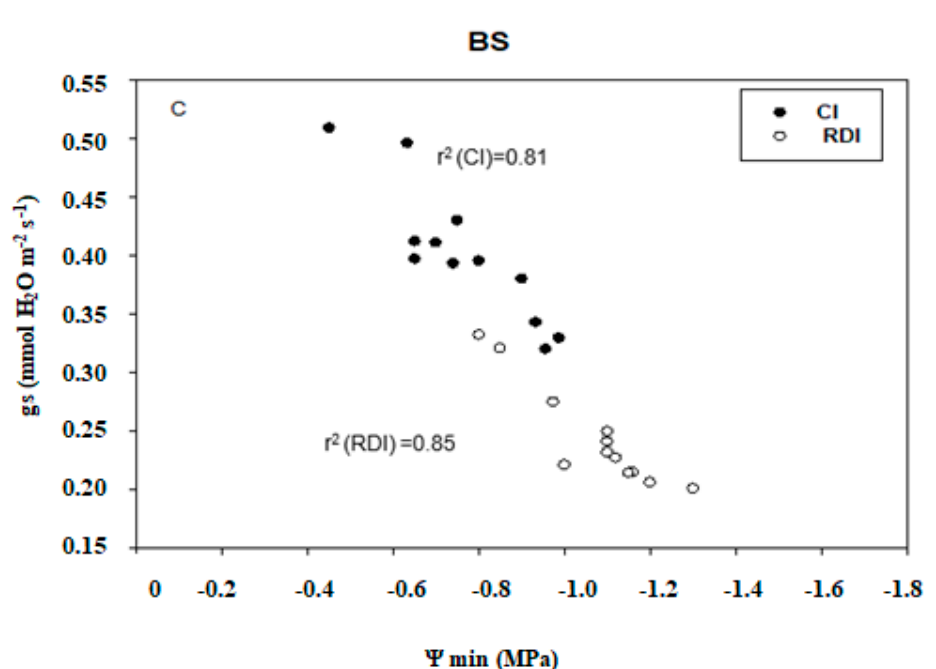
Figure 5. Relationship between stomatal conductance rate (gs) (mmol H 2 O m − 2 ·s − 1 ) and Predawn water potential (MPa) in three Black Diamond ( A ), Black Gold ( B ), and Black Star ( C ) cultivars in responses to both water treatments (CI and RCI). Values are the means of twelve samples ( n = 12) ± standard deviation. r 2 (CI), r 2 for control irrigation; r 2 (RDI), r 2 for deficit irrigation.